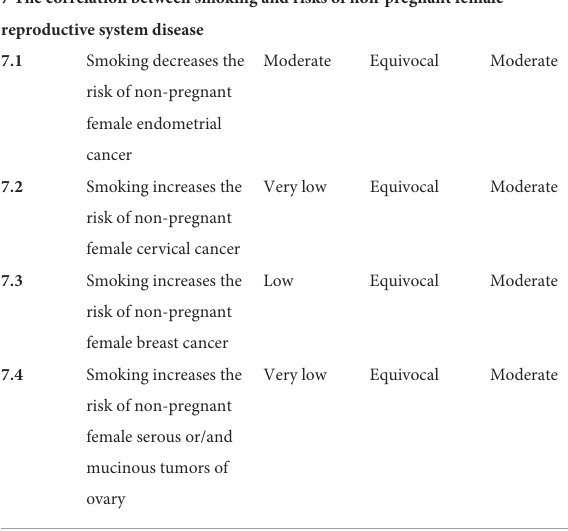
TABLE 3 The correlation between smoking and risks of female reproductive system